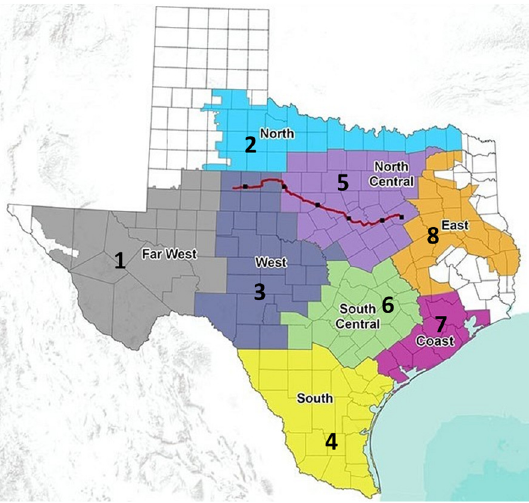
Figure 4. 2000-bus synthetic Texas power grid diagram [28].